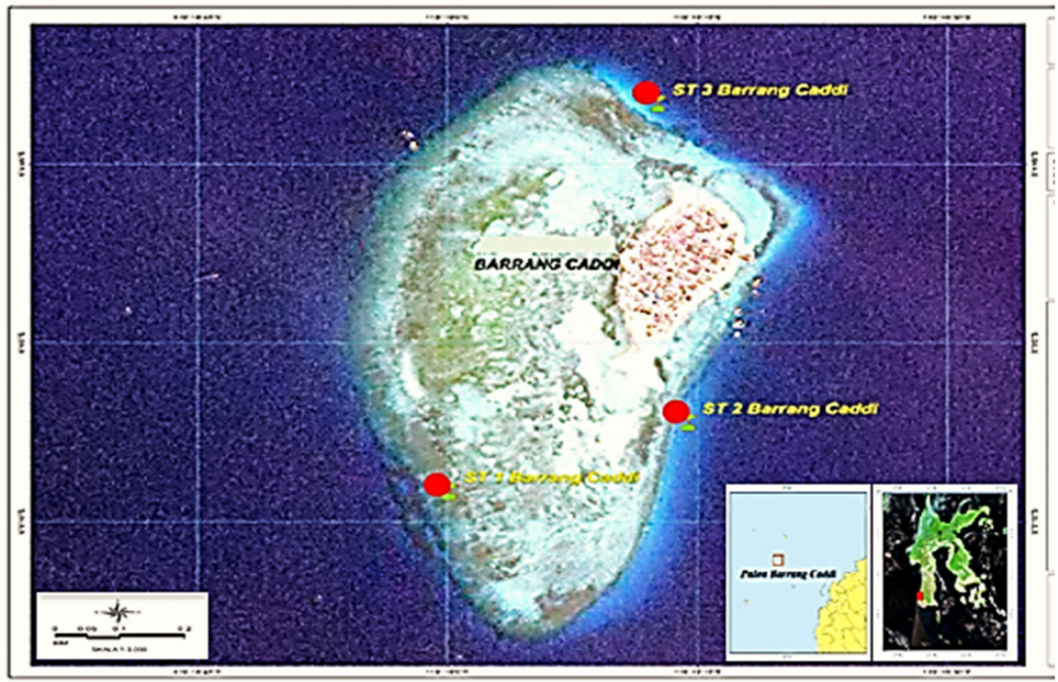
Figure 1. Map of Barrang Caddi Island (BCI). The red dots indicate the sampling stations (STs). Sediment, sponge, seawater, and fish samples were obtained from three